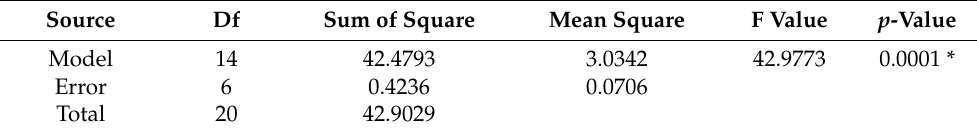
Table 3. Analysis of variance for the regression model (R 2 = 0.990126).